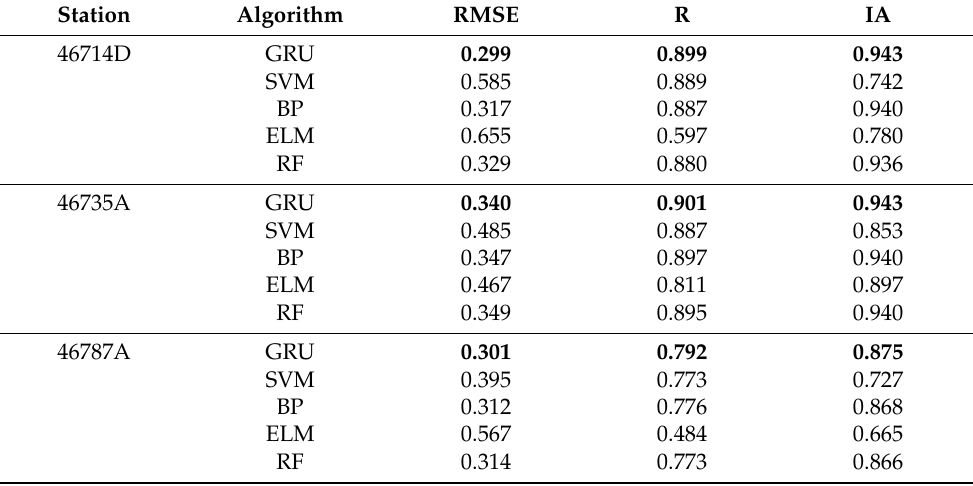
Table 4. Error indices of predicted SWH with lead times of 6